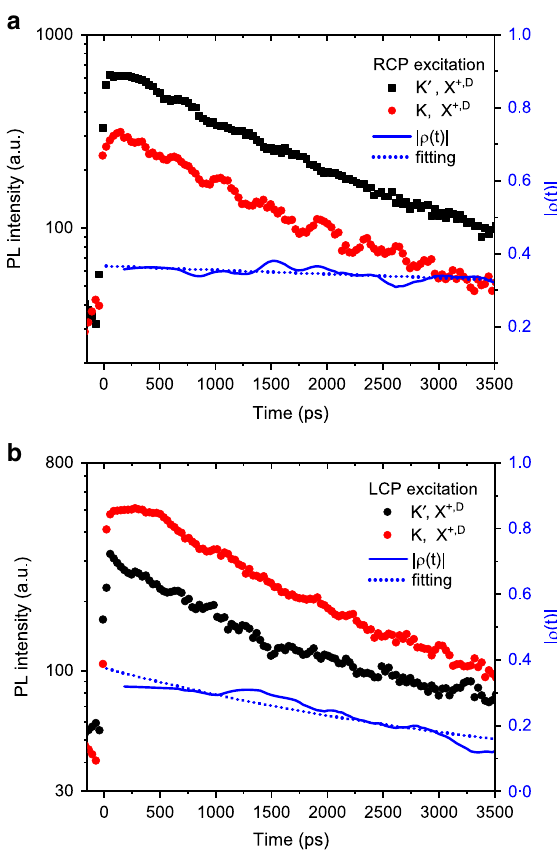
Fig. 4 Dark exciton valley dynamics. Time-resolved PL of the dark hole trion in a hole doped WSe 2 sample (both gates at − 2.2 V) under a magnetic fi eld of 8 T for the RCP ( a ) and LCP ( b ) excitation. Black and red symbols represent the PL of the Zeeman-split dark hole trion associated with the K ′ and K valleys, respectively. The solid blue curves are the valley contrast j ρ t ð Þj as de fi ned in the main text. The dotted blue curves are a single- exponential fi t, revealing a decay time constant of 32 ± 4 ns and 4.1 ± 0.2 ns, respectively, for the RCP and LCP